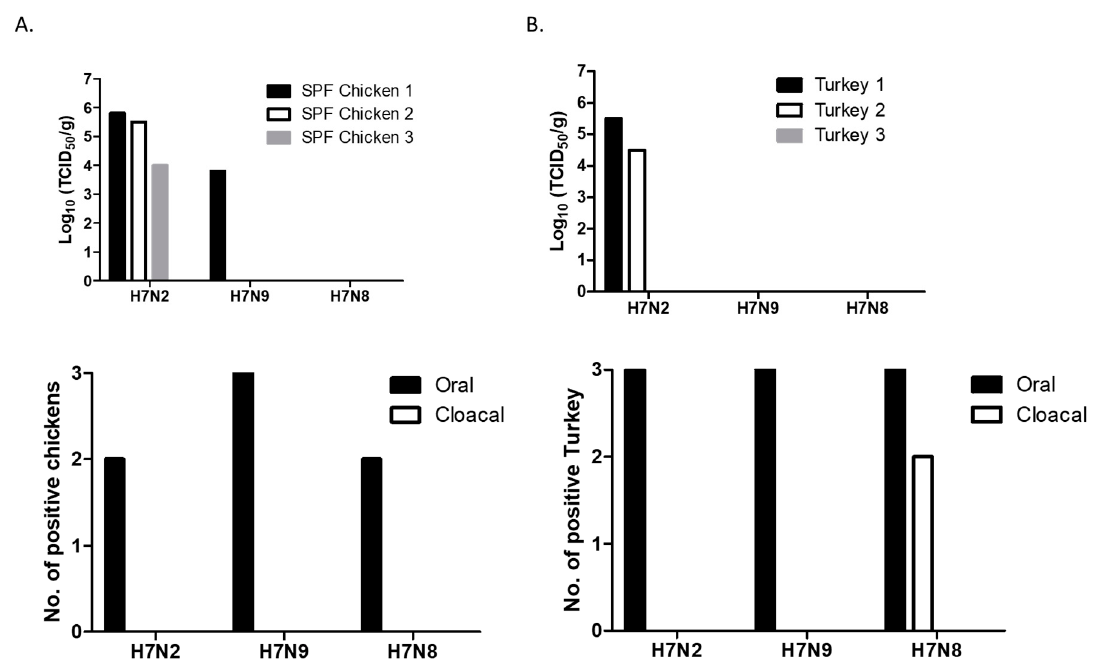
Figure 2. Replication and shedding of H7 LPAI viruses in the trachea of 2-week-old SPF (specific-pathogen-free) chickens ( A ) and turkeys ( B ). Birds were intranasally inoculated with 200 μ L of each virus (10 7 pfu/mL). Trachea samples were collected for virus titration in MDCK cells on days 3 pi. Virus titers were expressed as 50% tissue culture infectious dose (TCID 50 /g). Swab (oral and cloacal) samples were collected for virus shedding. Viral replication was confirmed by amplifying the virus in MDCK cells. At 72 h post-infection, viral replication was determined by HA assay.